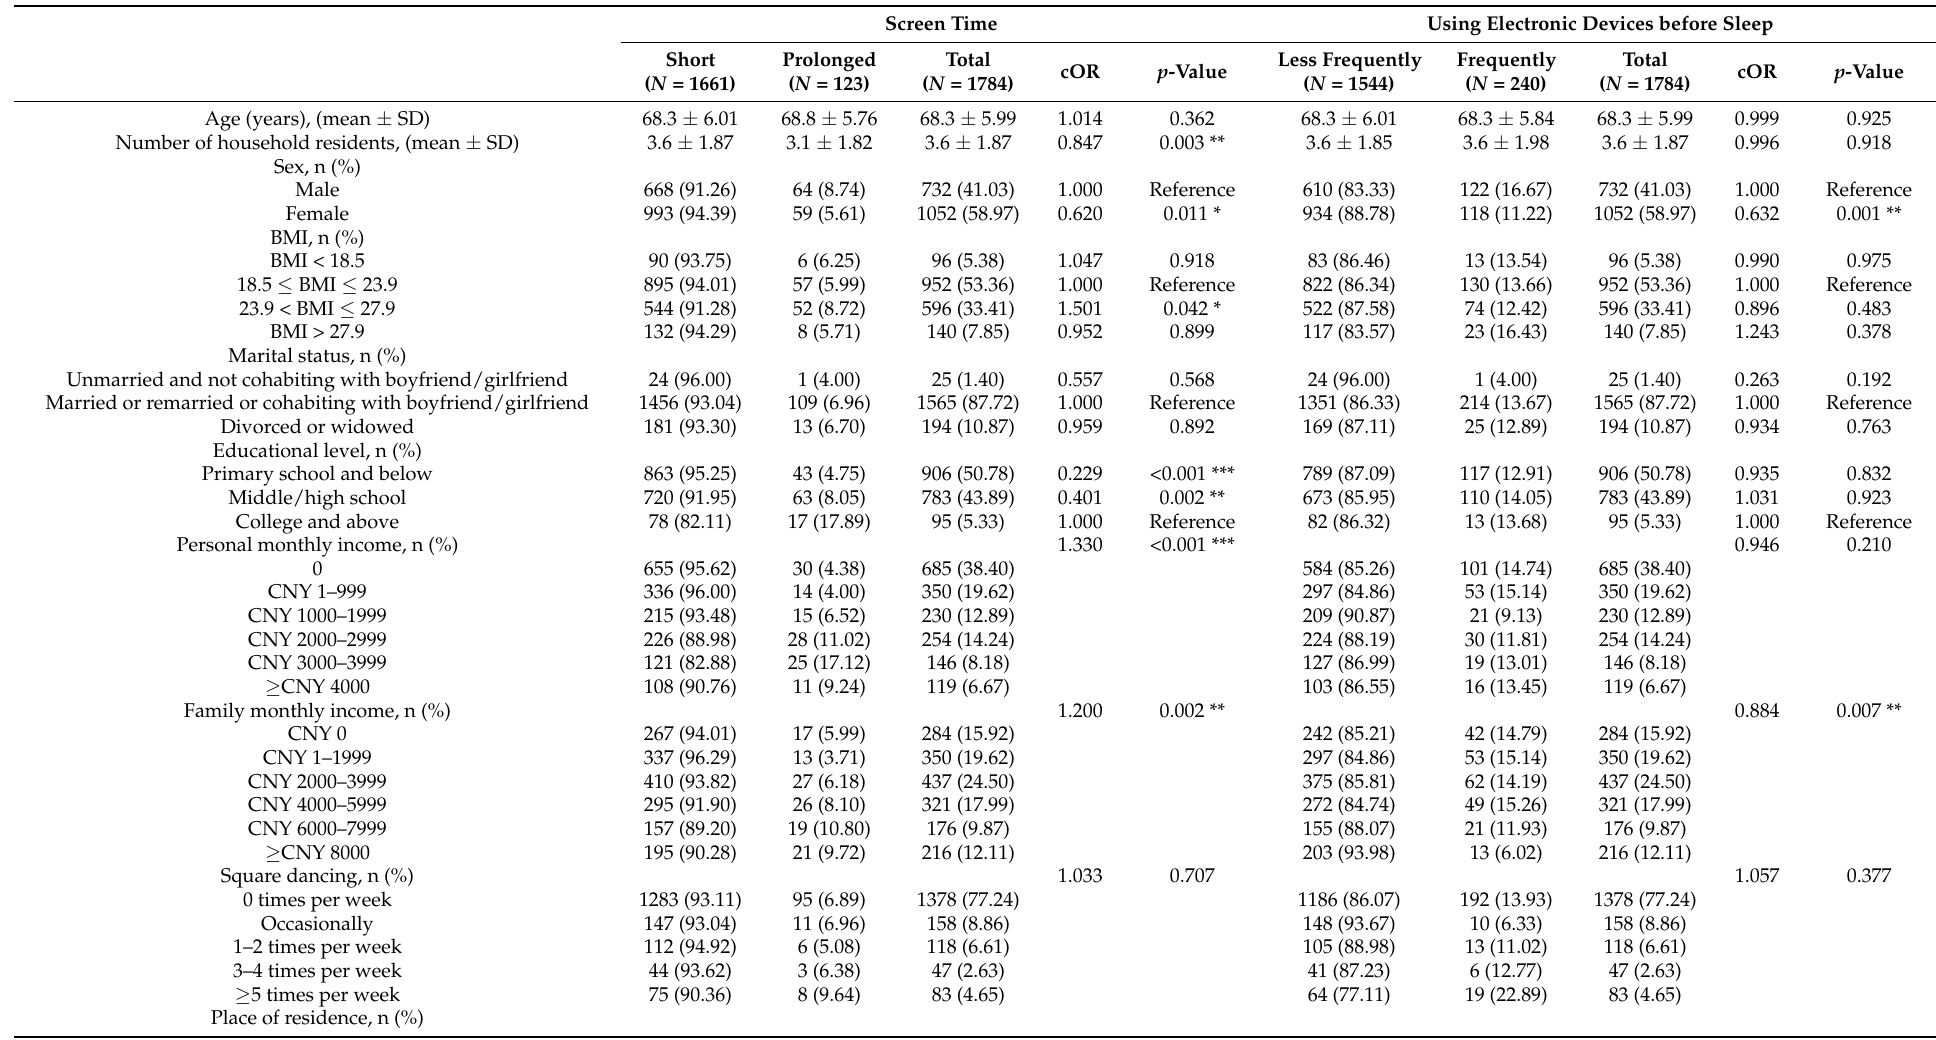
Table 1. Characteristics of participants and